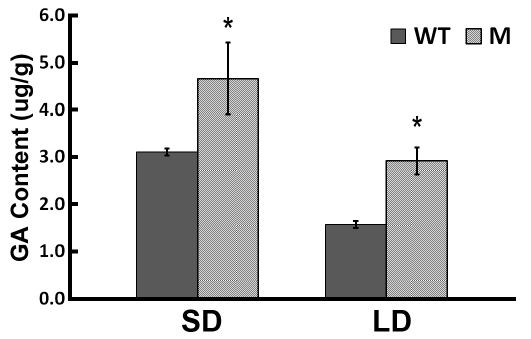
Figure 2. GA content in the leaves of WT and M plants grown under LD or SD. Significant differences were determined by Duncan’s multiple range test ( p < 0.05, n = 3). * means significantly difference.